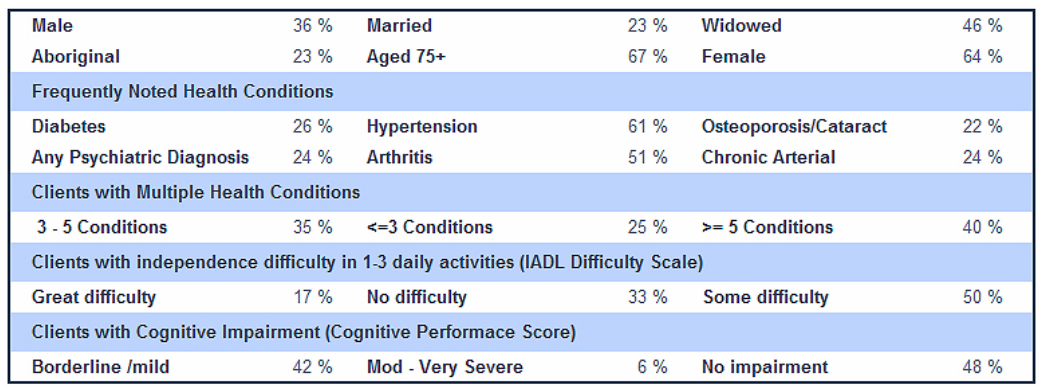
Figure 15. Senior residents